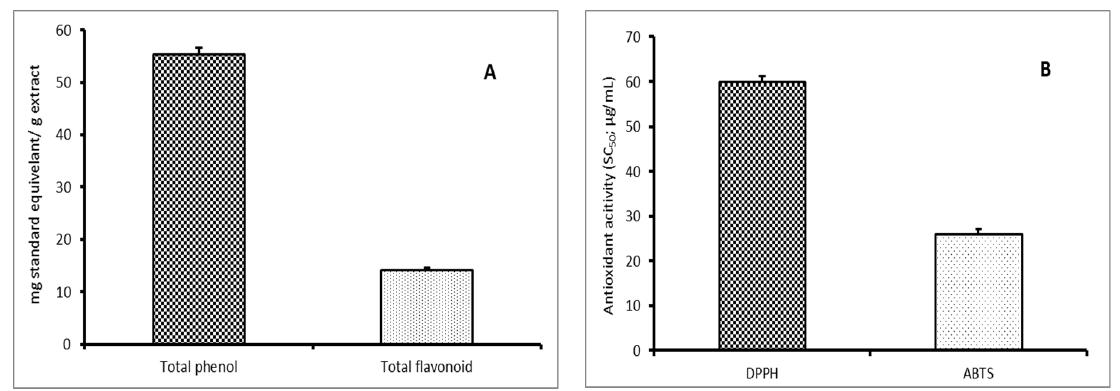
Figure 1. TPs (mg GAE/g extract) and TFs (mg QE/g extract) contents ( A ), 2,2 ′ -azino-bis(3-ethylbenzothiazoline-6-sulfonic acid (ABTS) activity (SC 50 ; µg mL − 1 ) and 1,1-diphenyl-2-picrylhydrazyl (DPPH) activity (SC 50 ; µg mL − 1 ) ( B ) of the methanolic extract acquired from green coffee seeds flour.